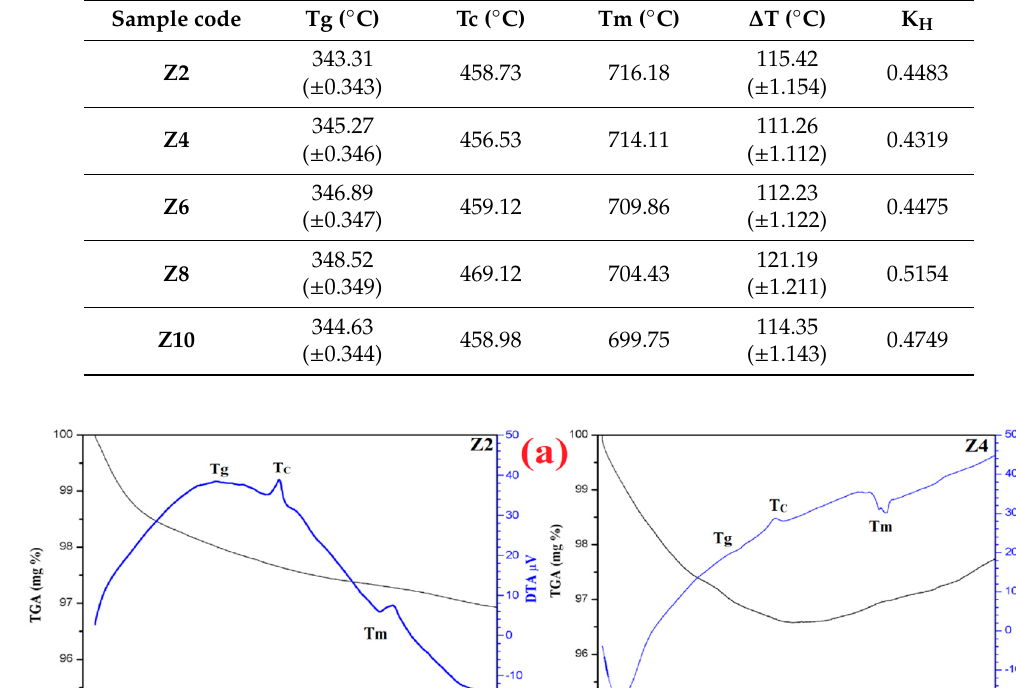
Table 3. Thermal properties of ZnO doped phosphate bioactive